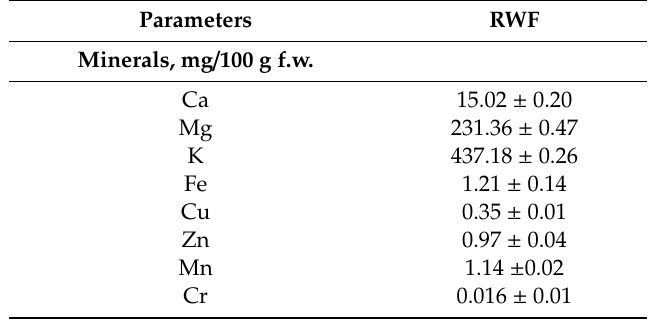
Table 2. Chemical composition and mineral content of rice wholemeal flour (RWF). Parameters RWF Minerals, mg / 100 g f.w. Ca 15.02 ±